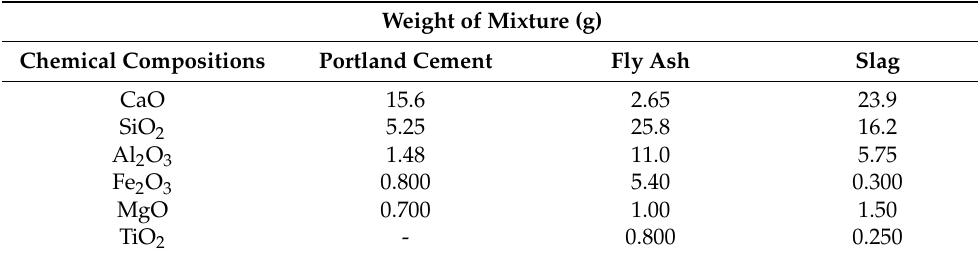
Weight of Mixture (g)